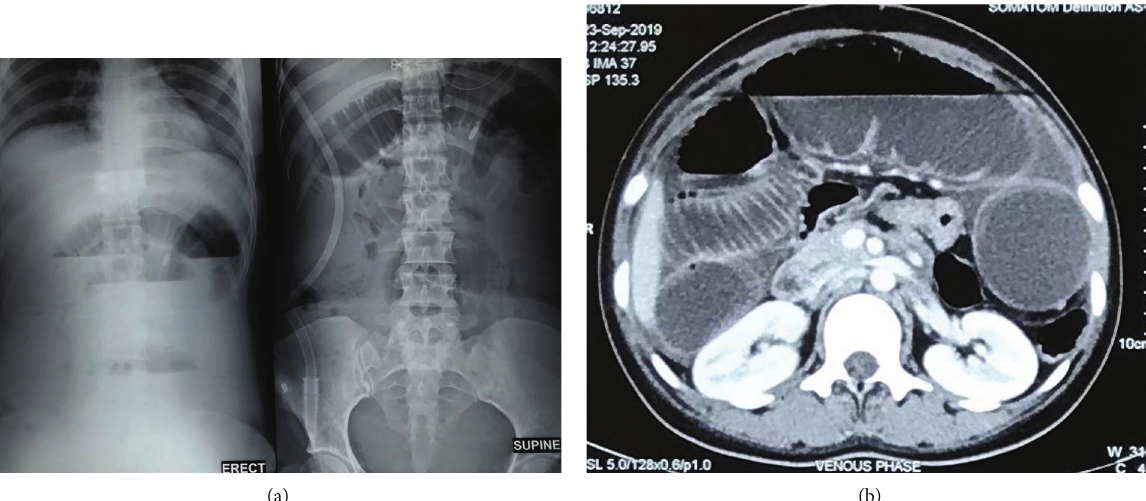
Figure 2: (a) X-ray showing air fl uid levels in the left and dilated loops of small bowel with prominent valvulae conniventes suggestive of small bowel obstruction. (b) CECT scan showing dilated bowel loops suggestive of intestinal